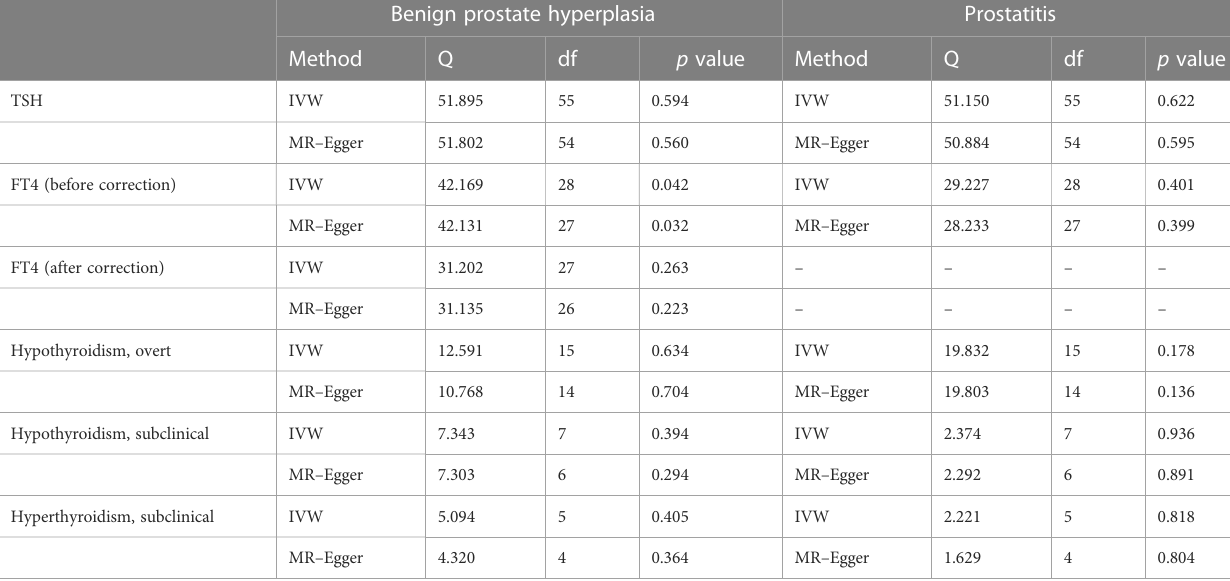
TABLE 1 Heterogeneity tests in the causality of thyroid function and benign prostatic diseases.